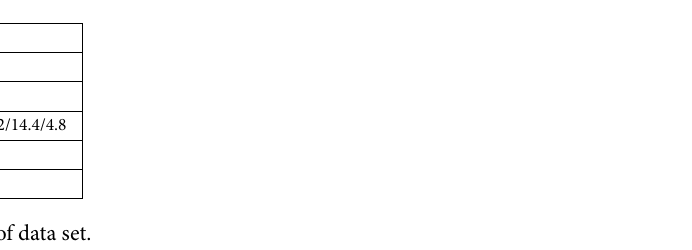
Table 2. Patient characteristics of data